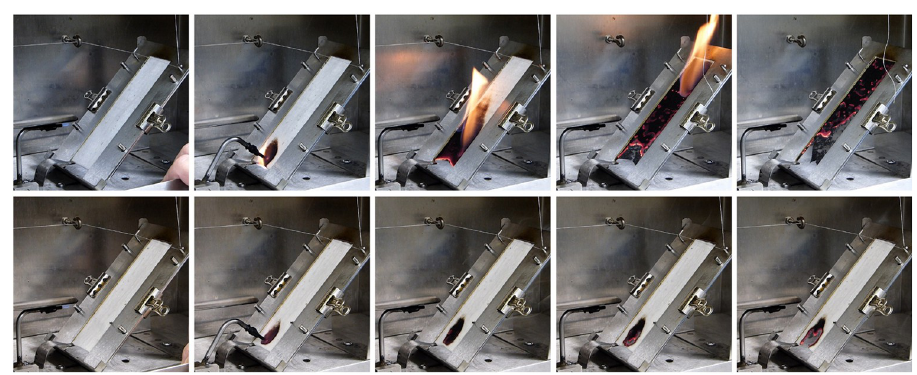
Fig 2. Time series of 45˚ incline flame test of non-woven fabrics from the MAGIC RILs with the inferior HRC and the most superior HRC. Each image is 5 seconds apart. Top series is fabric made from RIL-225, which like all untreated textiles produced from conventional cultivated white cottons, was fully consumed by flame in ~15s. Bottom series is RIL-385, which self-extinguished. See also Fig 3 and S1 and S2 Movies.